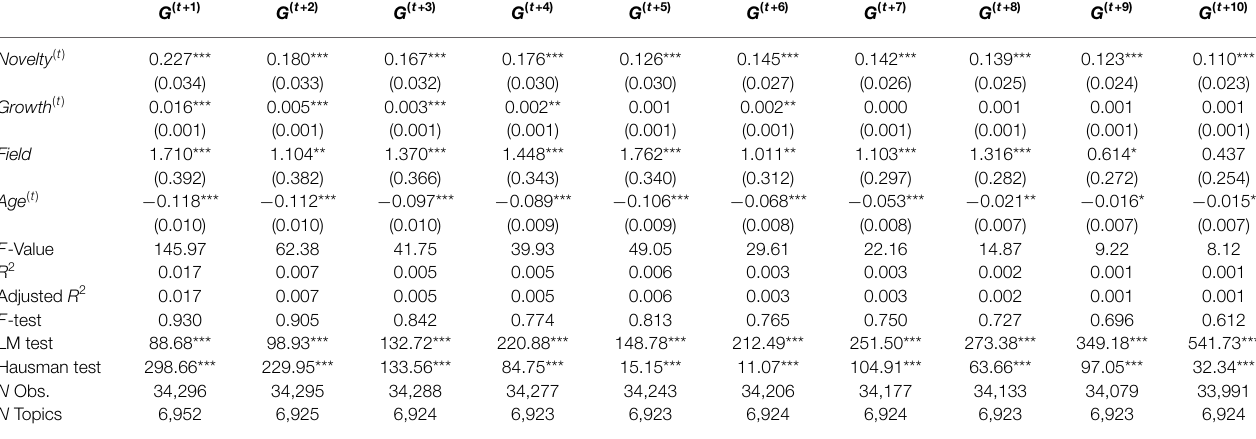
TABLE 5 | Growth ( t + ∆ t ) random-effect models